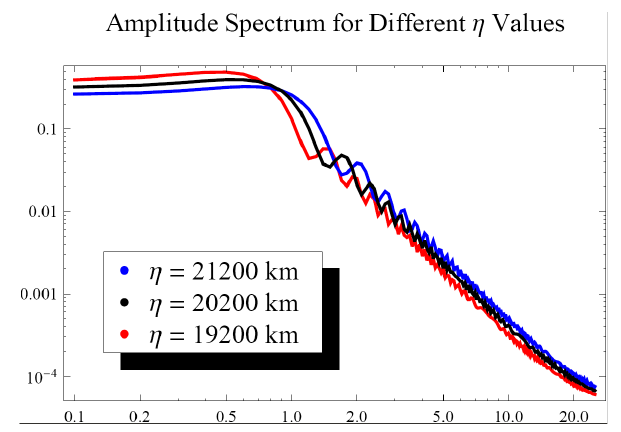
Fig. 3. Amplitude frequency spectrum (in Hz) with varying turbu- lence location